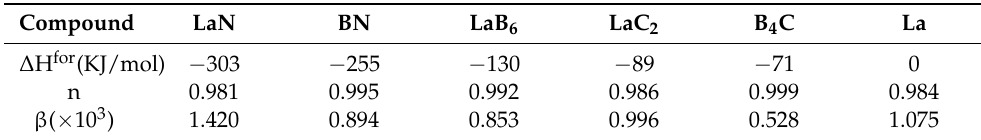
Table 2. The values of ∆ H for , n, and β (at λ = 6.65 nm) for LaN, BN, LaB 6 , LaC 2 , B 4 C, and La. Reprinted from [56] with permission from